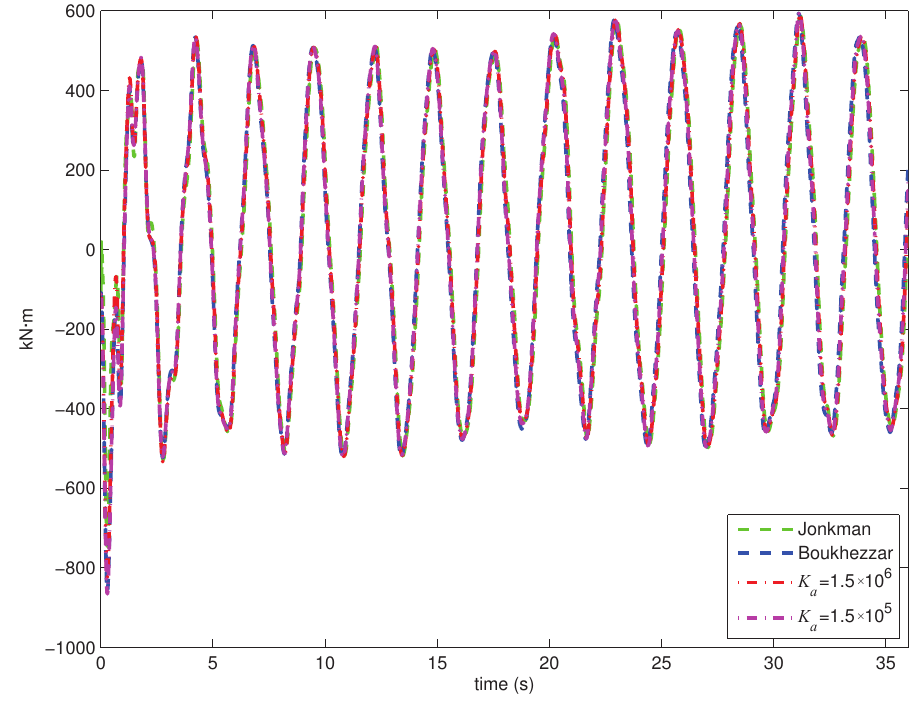
Figure 12. Blade edge-wise bending